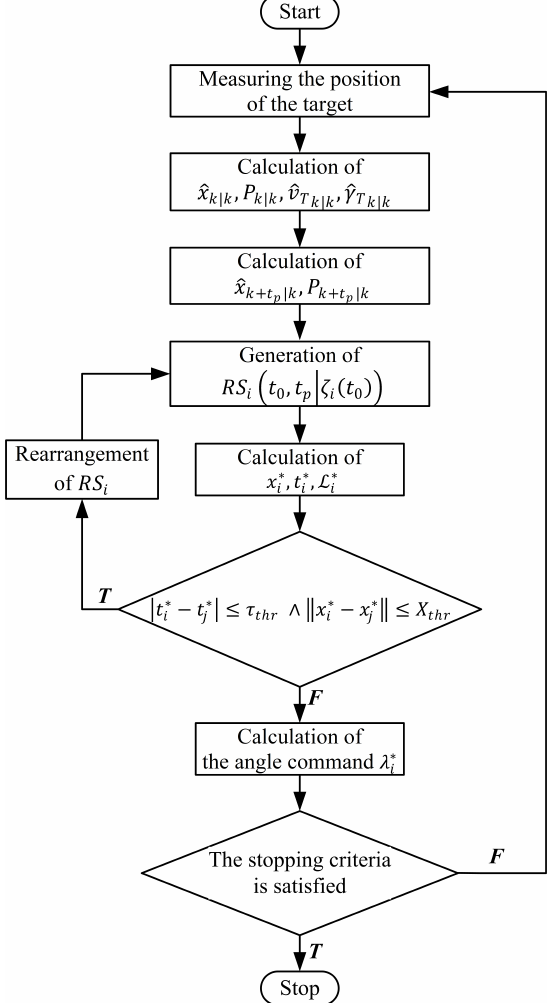
Figure 3. Flow diagram of the proposed cooperative guidance